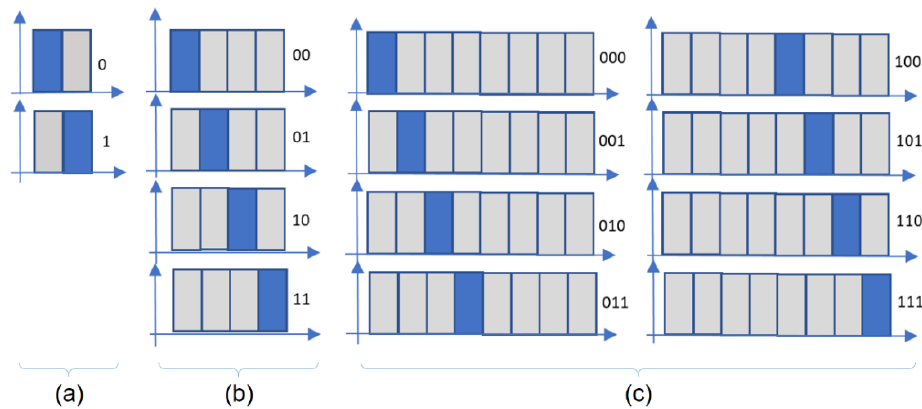
Figure 2. n -PPM examples: ( a ) n = 2, binary PPM (Manchester code); ( b ) n = 4, 4-ary PPM; ( c ) n = 8, 8-ary PPM.